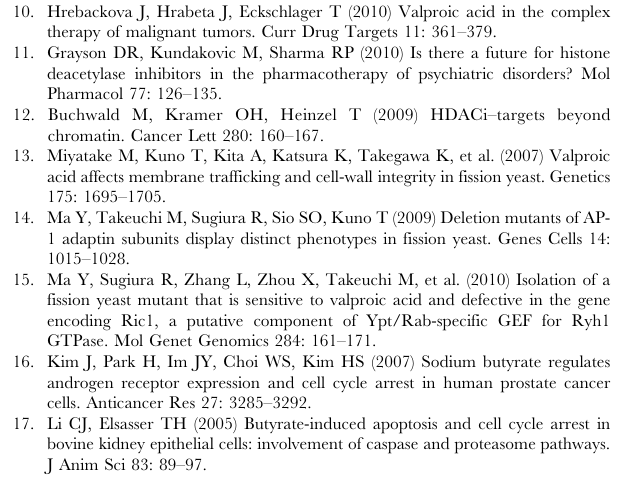
Figure S4 Effect of SB on cell-wall digestion by b - glucanase. Wild-type cells were assayed for zymolyase sensitivity with or without SB treatment. The D pmk1 cells were assayed as a positive control. The wild-type cells and D pmk1 cells were cultured in YPD at 27 u C for 10 hours to exponential phase. Then the wild-type and D pmk1cells were treated with the indicated concentrations of SB for 6 hours and incubated with 100 m g/ml of b -glucanase (zymolyase 20T) at 27 u C with vigorous shaking. Cell lysis was monitored by measuring optical density at 660 nm. The value before adding the enzyme was taken as 100%. The data are representative of three independent experiments. (TIF) Figure S5 VPA induced an increase in the cytoplasmic Ca2 + level in wild-type, D pmk1, D atf1 and D ppb1 cells. The wild-type, D pmk1, D atf1 and D ppb1 cells harboring pKB6892 were cultured and assayed as described in Figure 4A. The data represent the accumulated value ratio of each sample treated with the indicated concentrations of VPA to the basal (EMM) of wild-type cells. Standard deviations are from three independent experiments. Table S1 Summary of the gene name and products of VPA- and/or SB-sensitive mutants. Table S2 S. pombe genes identified in the screen for CaCl2-sensitivity in 148 sensitive